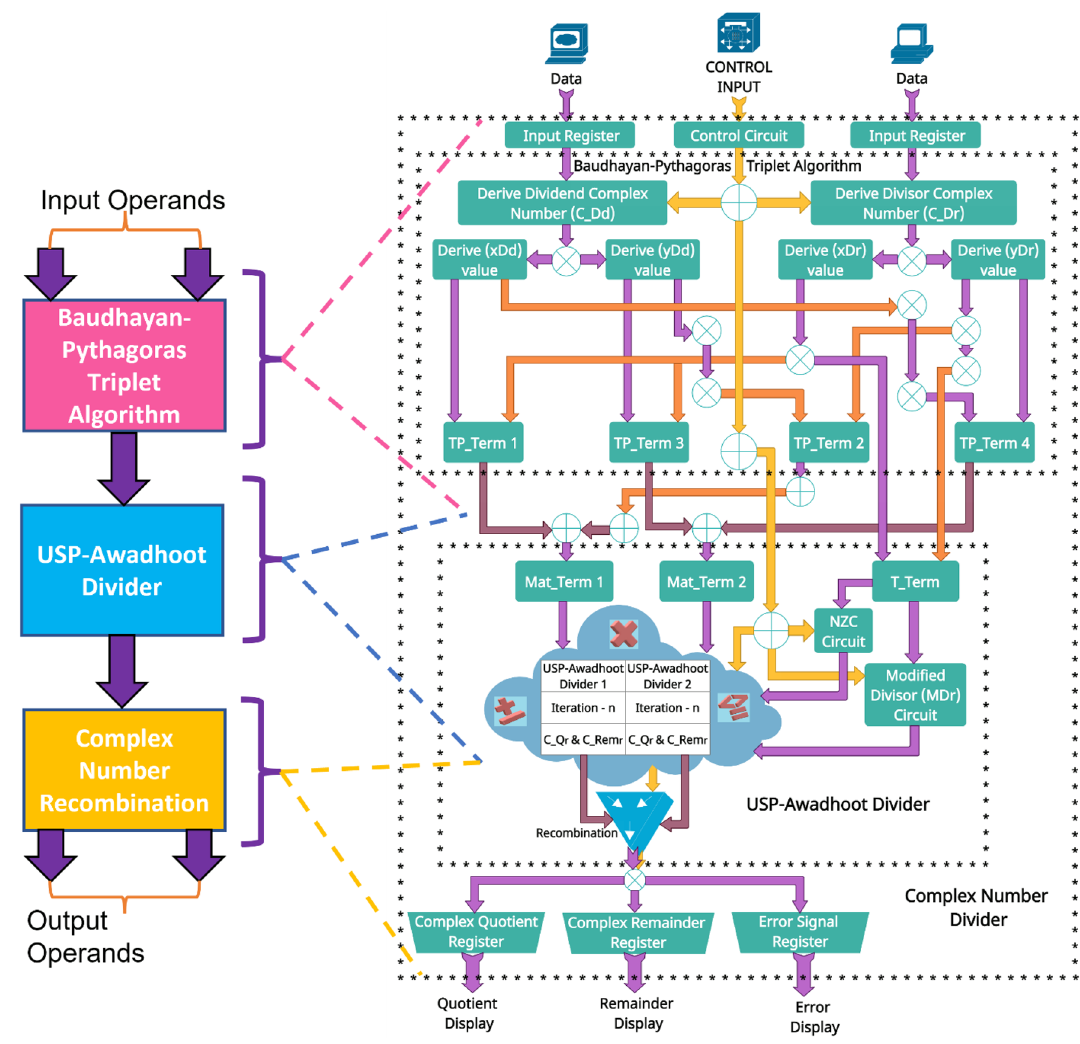
Figure 2. Schematic block diagram of the complex